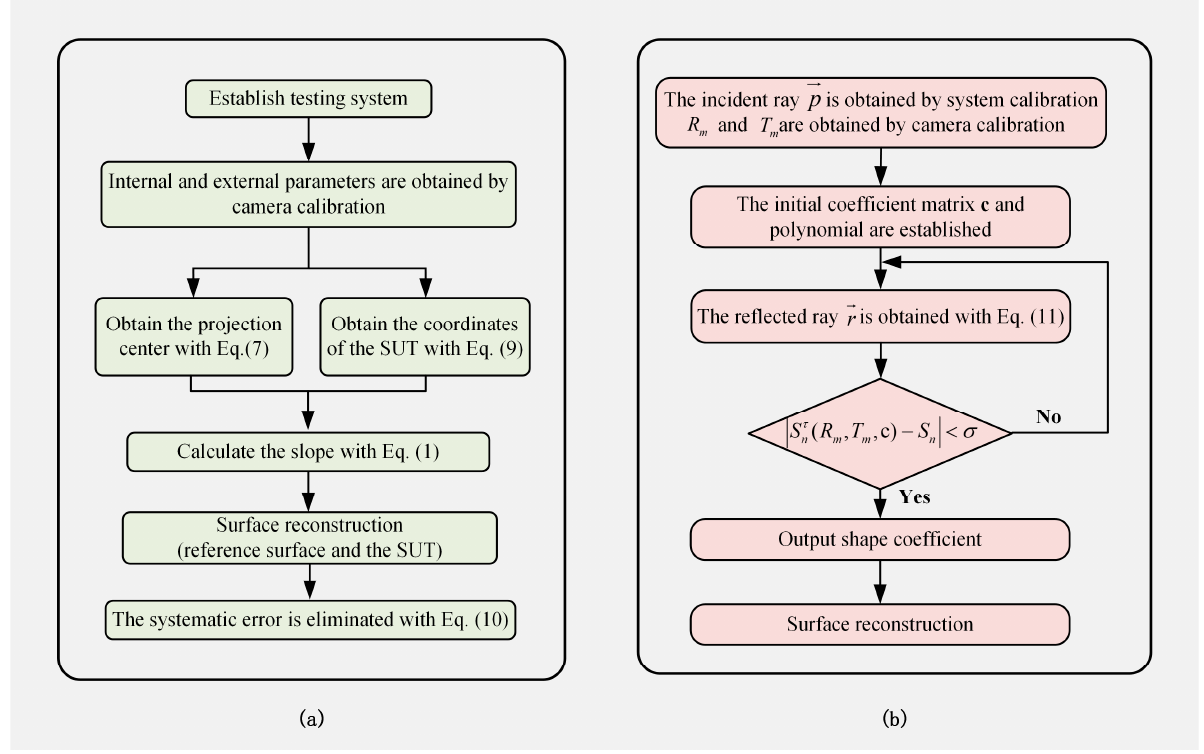
Figure 4. Flow charts: ( a ) PM; ( b ) MPMD.